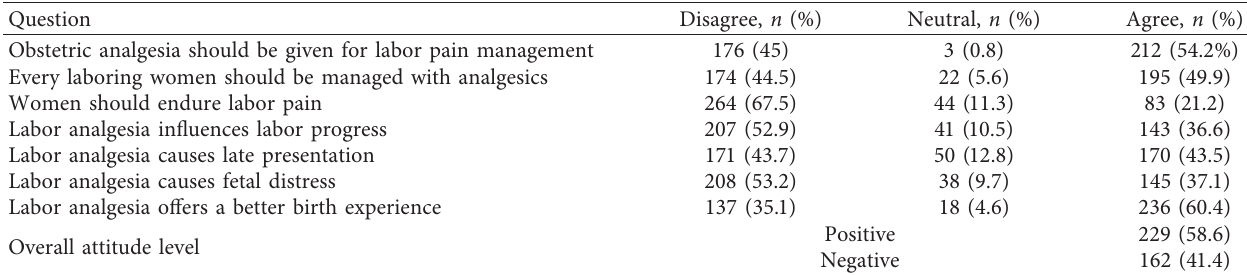
Table 4: Attitude toward obstetric analgesia among obstetric care providers in public hospitals of Addis Ababa, Ethiopia, 2020 ( n � 391). Question Disagree, n (%) Obstetric analgesia should be given for labor pain management Every laboring women should be managed with analgesics